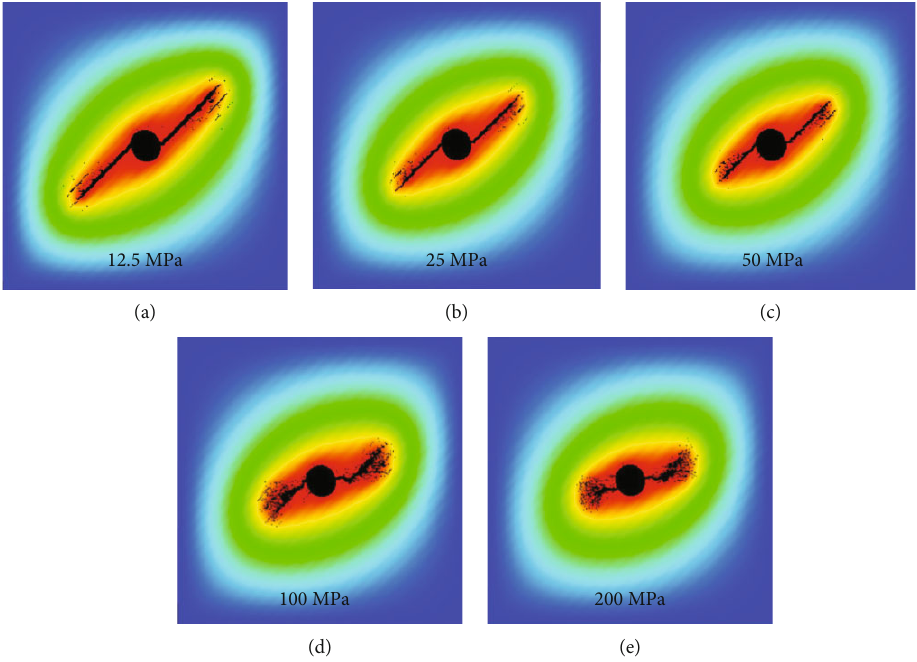
Figure 15: Final HF morphologies under di ff erent compressive strengths of